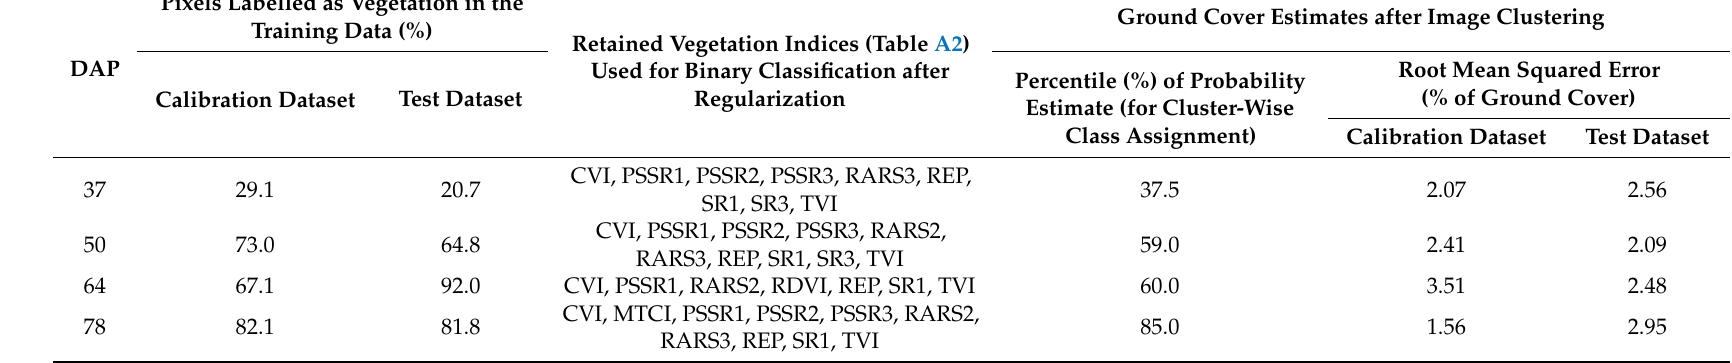
Table A3. Overview of vegetation segmentation procedure for ground-based